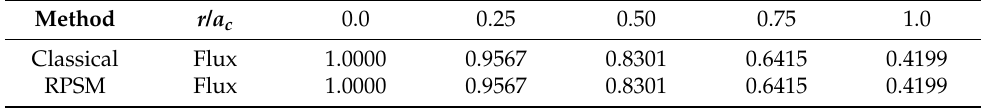
Table 6. Normalized flux in one-group reflected